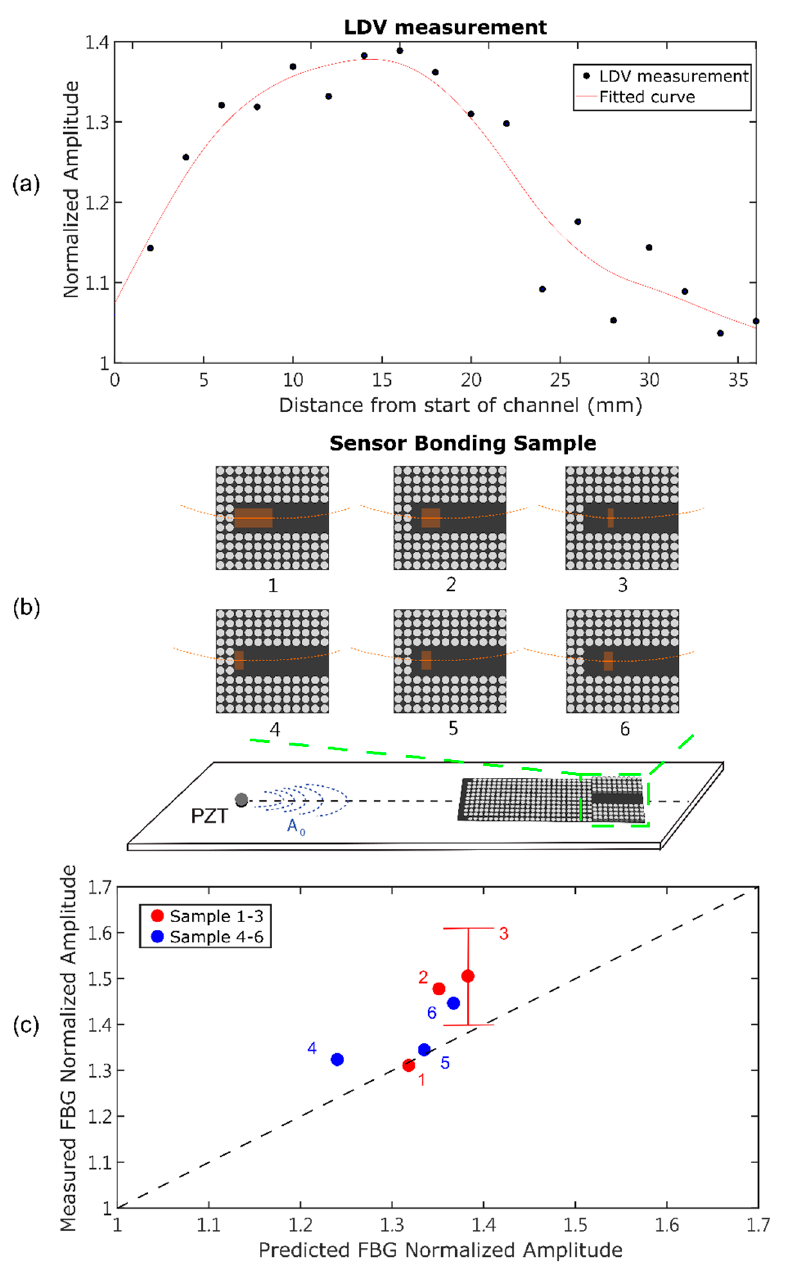
Figure 9. ( a ) Peak-to-peak normalized amplitude of the LDV responses measured along the waveguide channel. Curve fit to data is also plotted. ( b ) Optical fiber bond locations along the waveguide channel for measurements. ( c ) Comparison of measured and predicted FBG response for different bond locations. Table 2. FBG bonding parameters.